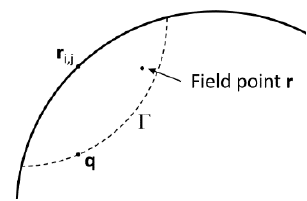
Figure 2. The matching interface Γ.